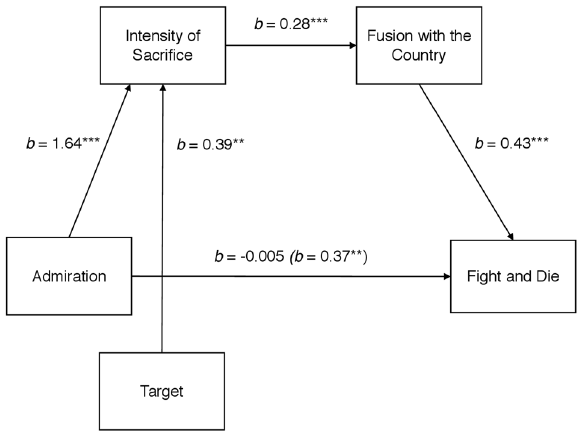
Fig. 3 Linear mediation model in Study 3 ( N = 231). Admiration increased willingness to fi ght and die for the country via intensity of sacri fi ce and fusion serially, b = 0.20, 95% CI [0.09, 0.33]. However, admiration did not in fl uence willingness to fi ght and die via intensity of sacri fi ces alone, b = 0.16, 95% CI [ − 0.004, 0.32], or identity fusion alone, b = 0.01, 95% CI [ − 0.14, 0.18]. Note. * p < 0.05; ** p < 0.01; *** p <